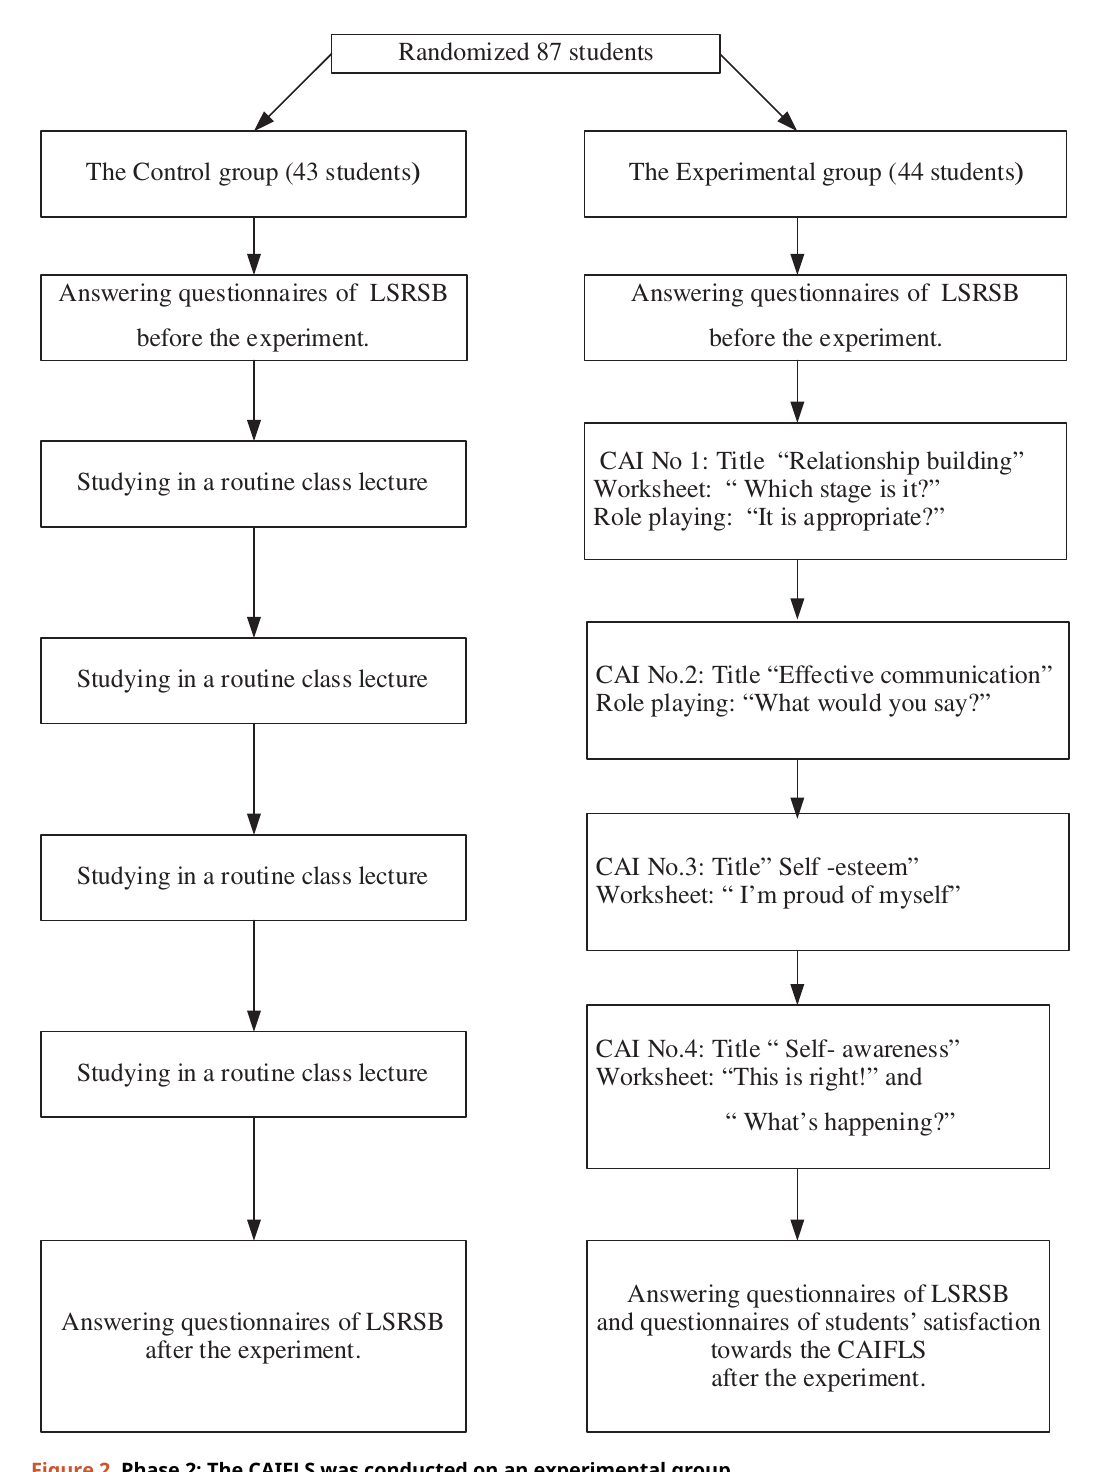
Figure 2. Phase 2: The CAIFLS was conducted on an experimental